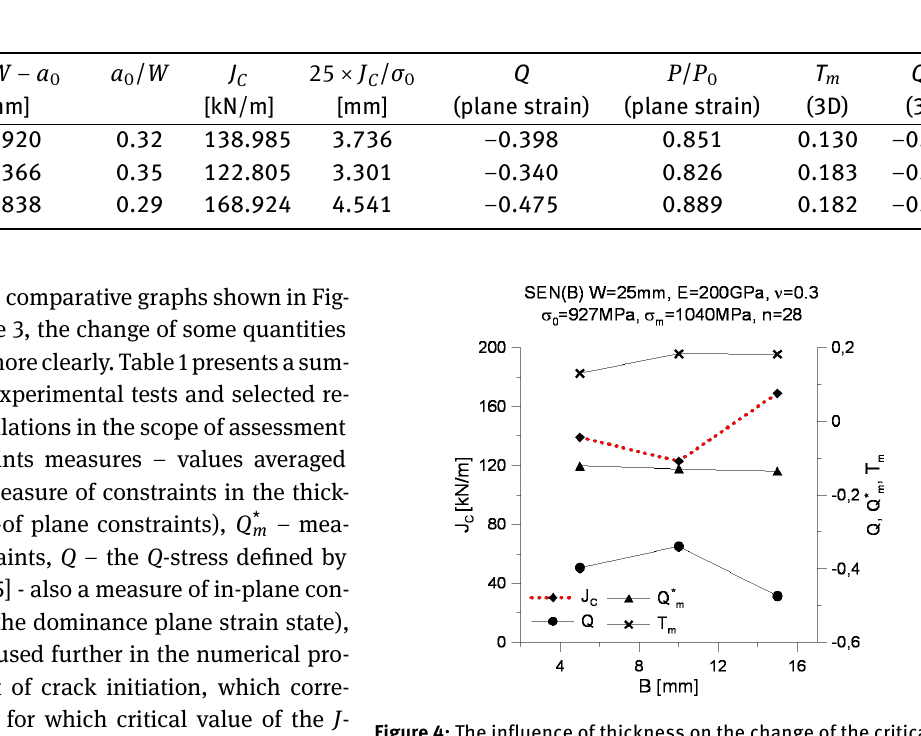
Table 1: List of results of numerical calculations for SEN(B) specimens with relative crack length a / W ≈ 0.30 for the moment of crack